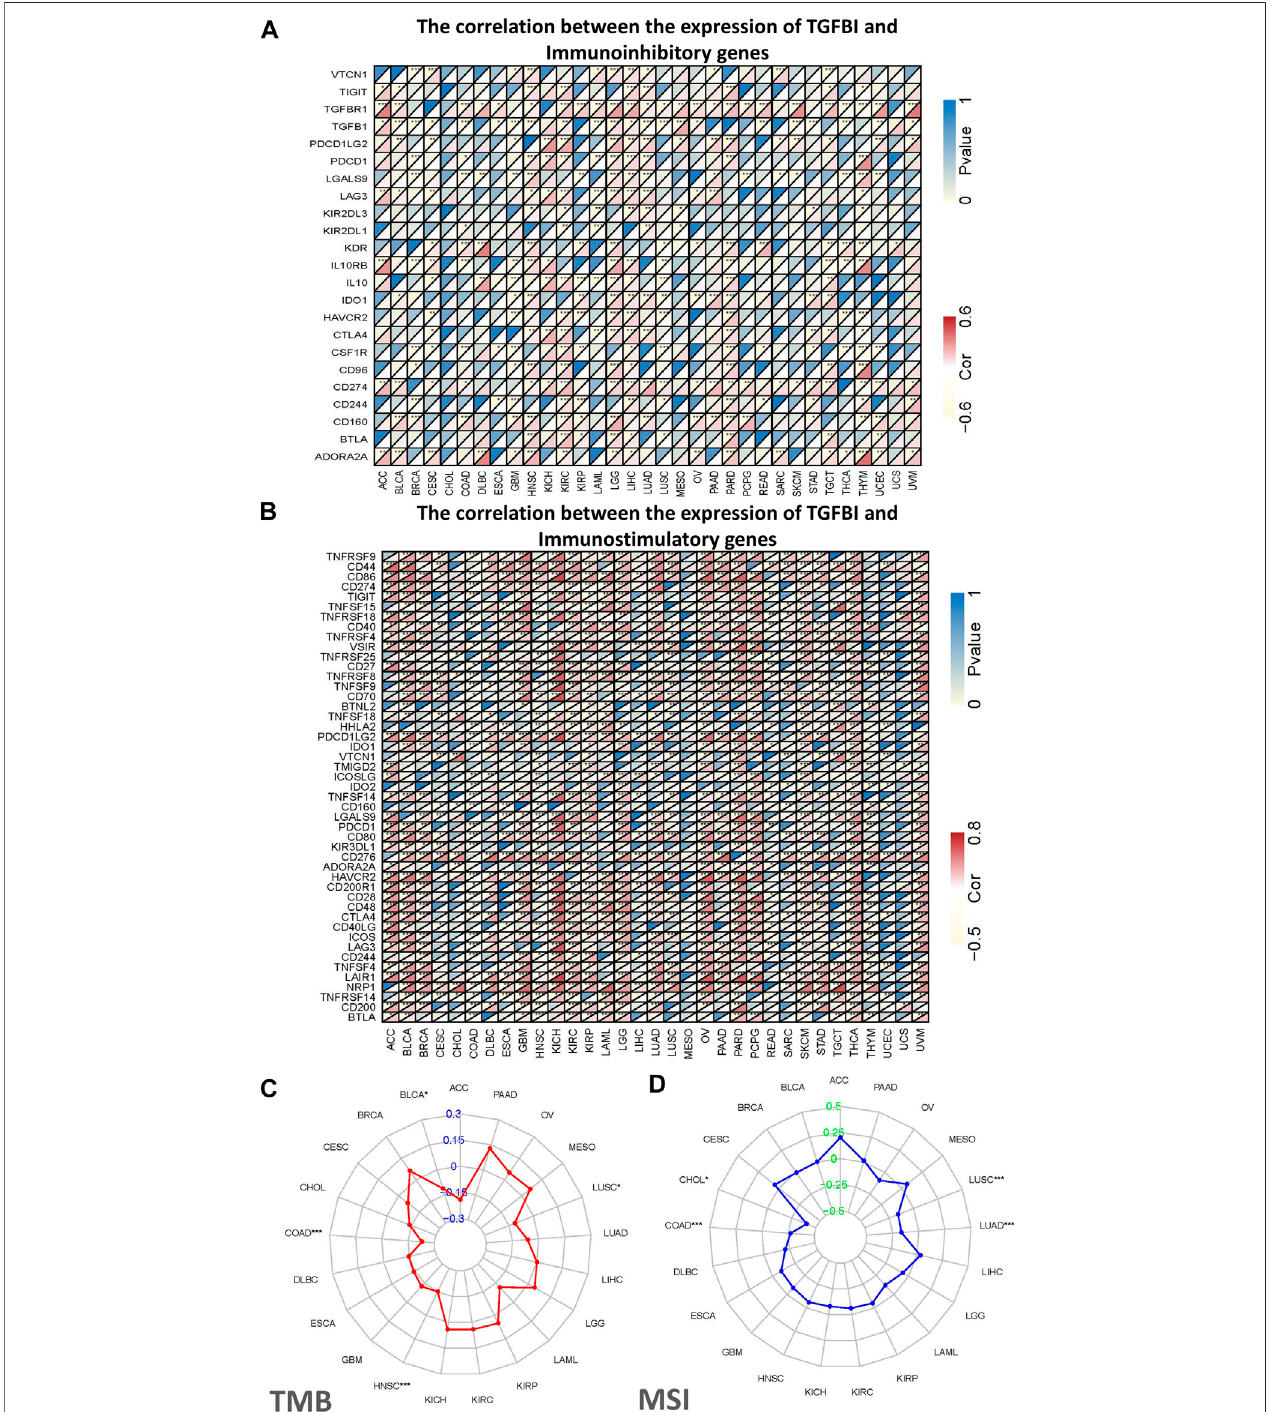
FIGURE 7 | Correlations of TGFBI expression with immunomodulatory genes, TMB, and MSI in various cancer types. Correlations of TGFBI expression with (A) immunoinhibitoryand (B) immunostimulatorygenes.Foreachpair,theupperlefttriangleiscoloredtorepresentthe p value,andthelowerrightoneiscoloredtoindicate Spearman ’ scorrelationcoef fi cient. (C) RadarchartoftheoverlapbetweenTMBand TGFBI expression.ThebluenumberrepresentsSpearman ’ scorrelationcoef fi cient. (D) Radar chart of the overlap between MSI and TGFBI expression. The green number represents Spearman ’ s correlation coef fi cient. * p < 0.05, ** p < 0.01, *** p <